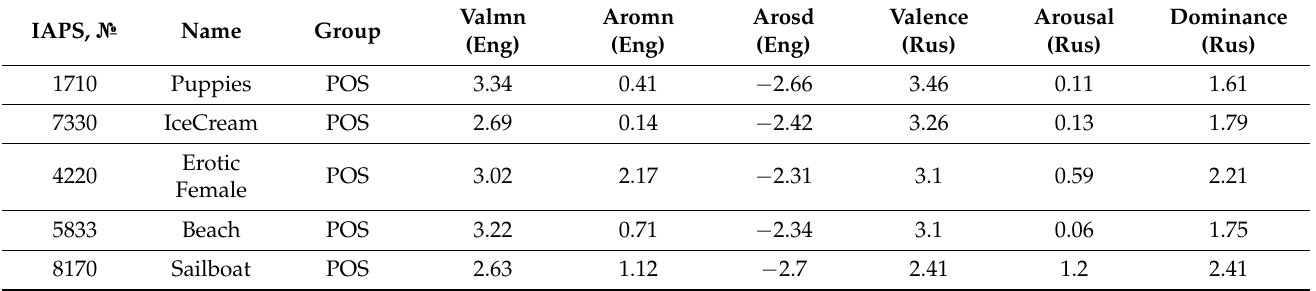
Table A3. Selection of incentive material according to IASP, taking into account the Russian